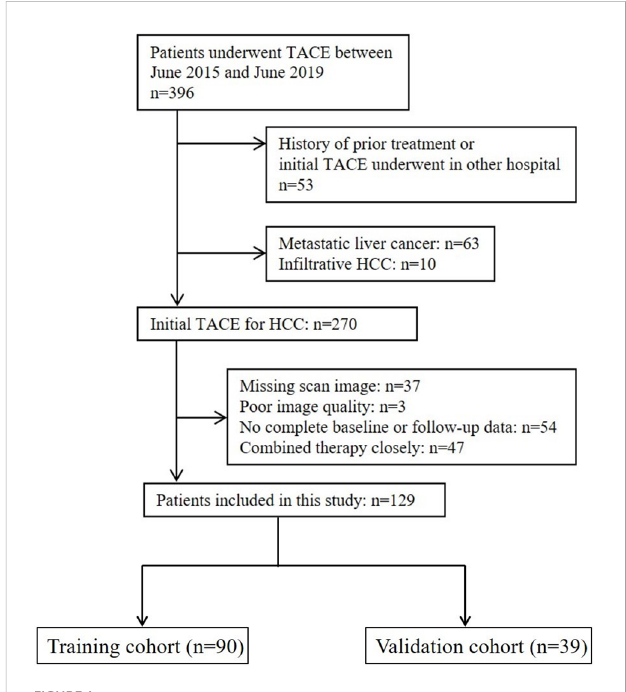
FIGURE 1 Flowchart of patients included and excluded in the